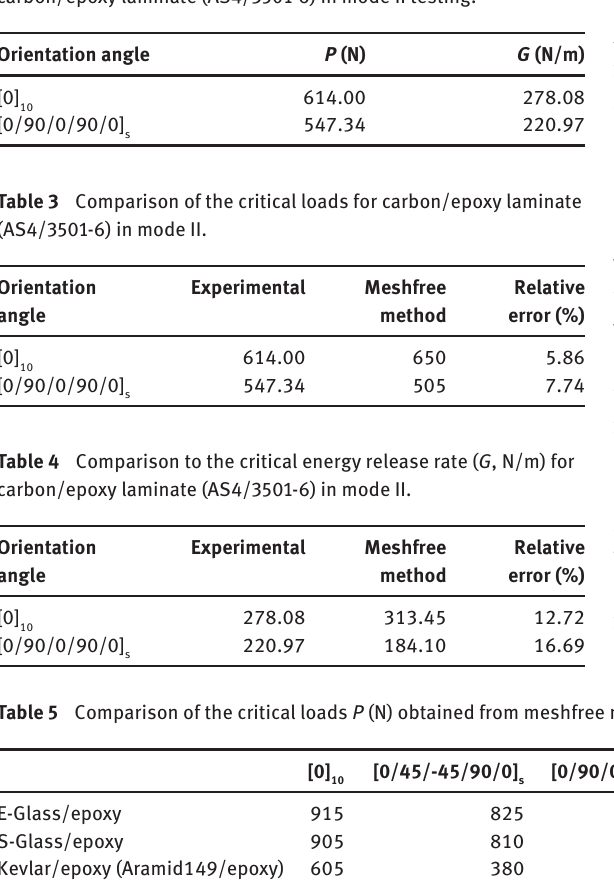
Table 2 The critical load and energy release rate amount for carbon/epoxy laminate (AS4/3501-6) in mode II